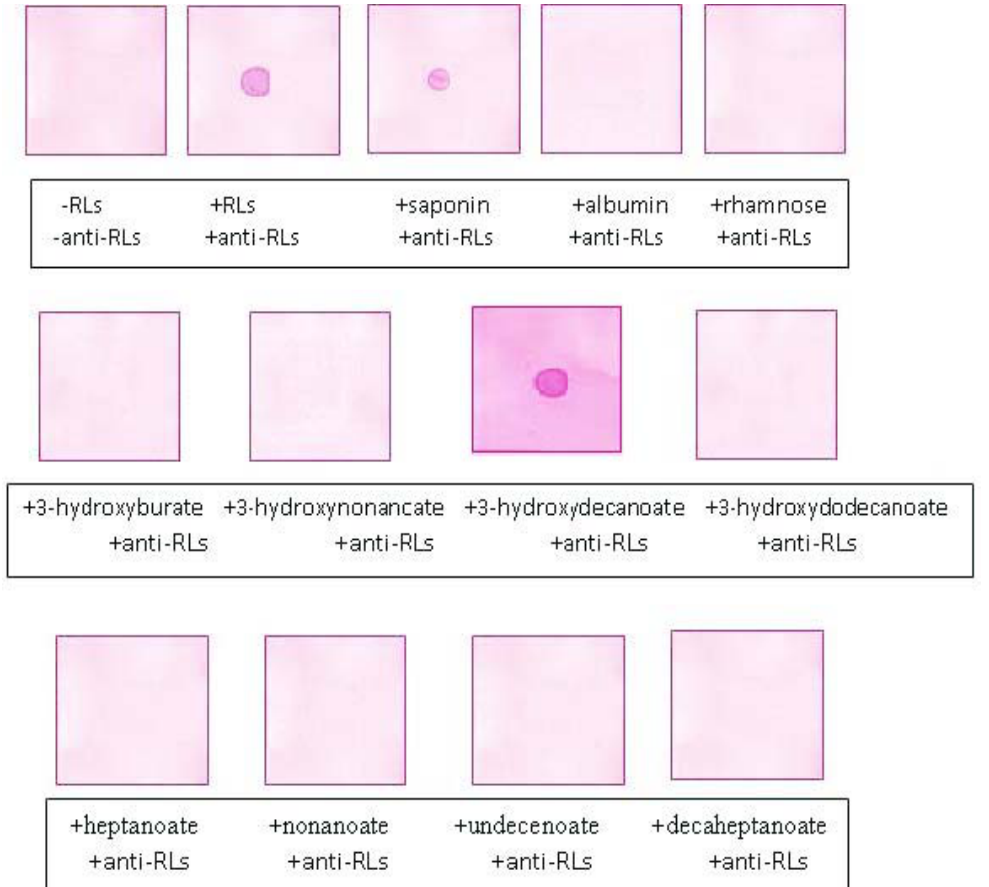
Figure 5. Recognition specificity of the anti- Tth RLs antibody against 3-hydroxyalkanoates and rhamnose. Immuno-dot blot assay performed by spotting Tth RLs, saponin, albumin, rhamnose, and various fatty acids such as 3-hydroxyburate, 3-hydroxynonanoate, 3-hydroxydecanoate, 3-hydroxydodecanoate, heptanoate, nonanoate, undecenoate, decaheptanoate, and then the membranes were probed with 1/500 dilution of rabbit polyclonal antiserum against Tth